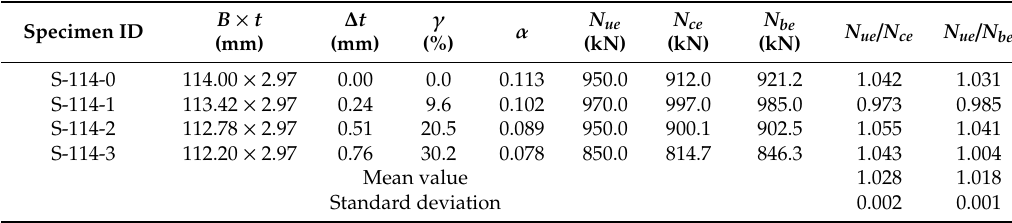
Table 2. Bearing capacity comparisons between the numerical results and experimental results of specimens exposed to acid rain